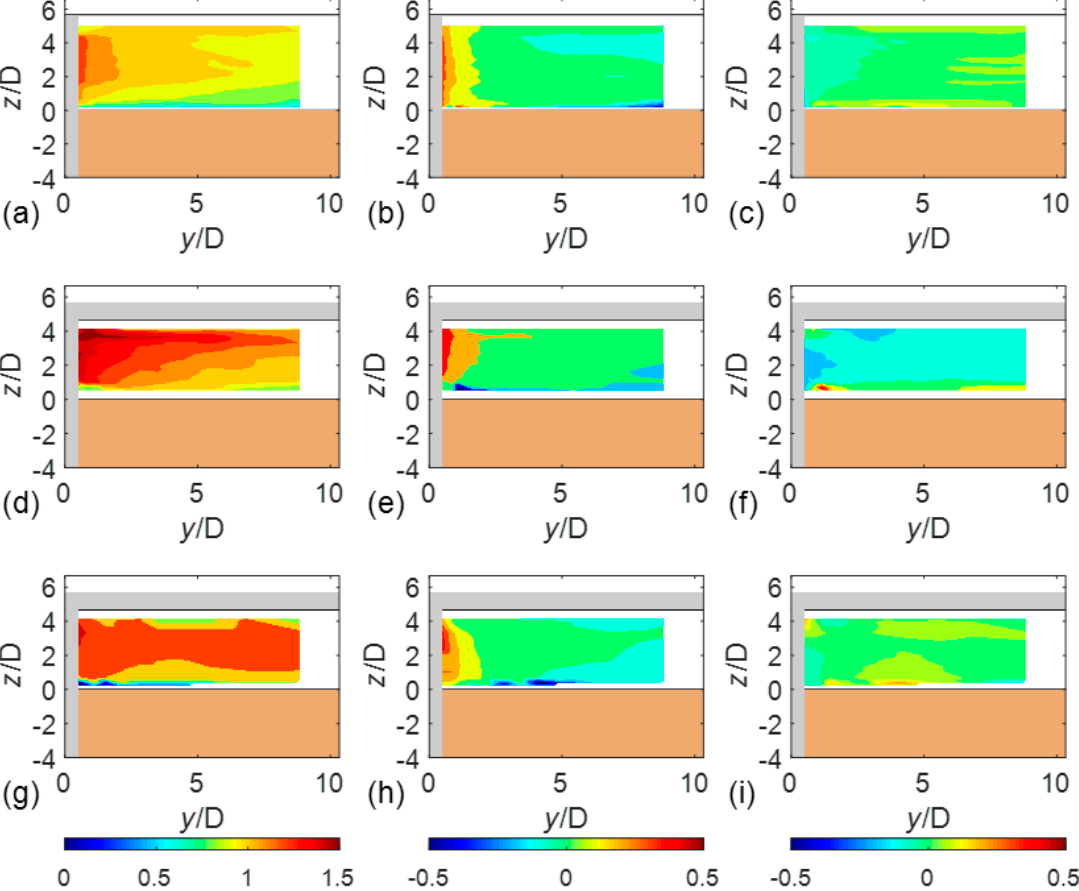
Figure 3. Average velocity components (in order left to right) u / U 0 , v / U 0 , and w / U 0 at t = 0 fixed bed conditions for ( a – c ) pier without deck; ( d – f ) 3D deck and pier; and ( g – i ) 6D deck and pier.